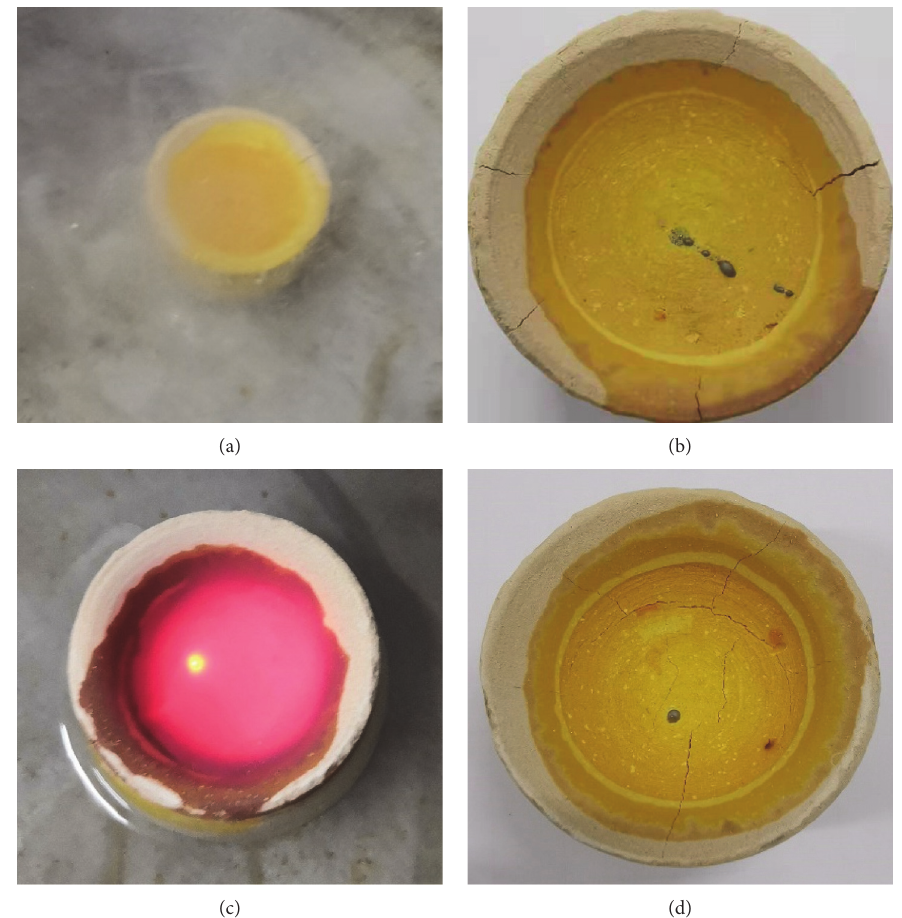
Figure 1: Magnesium ash dish cooling method. (a) Full immersion before cooling, (b) full immersion after cooling, (c) semi-immersion before cooling, and (d) semi-immersion after